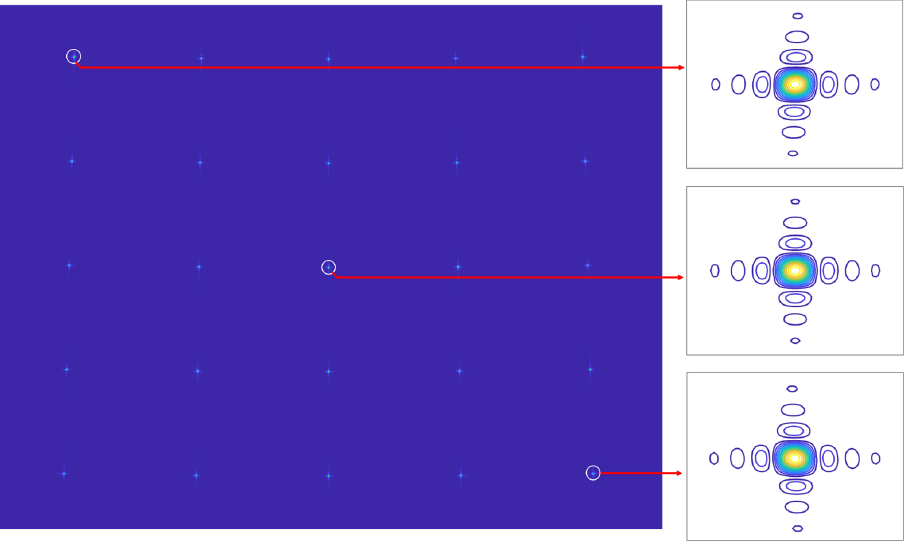
Figure 9. Imaging result of point